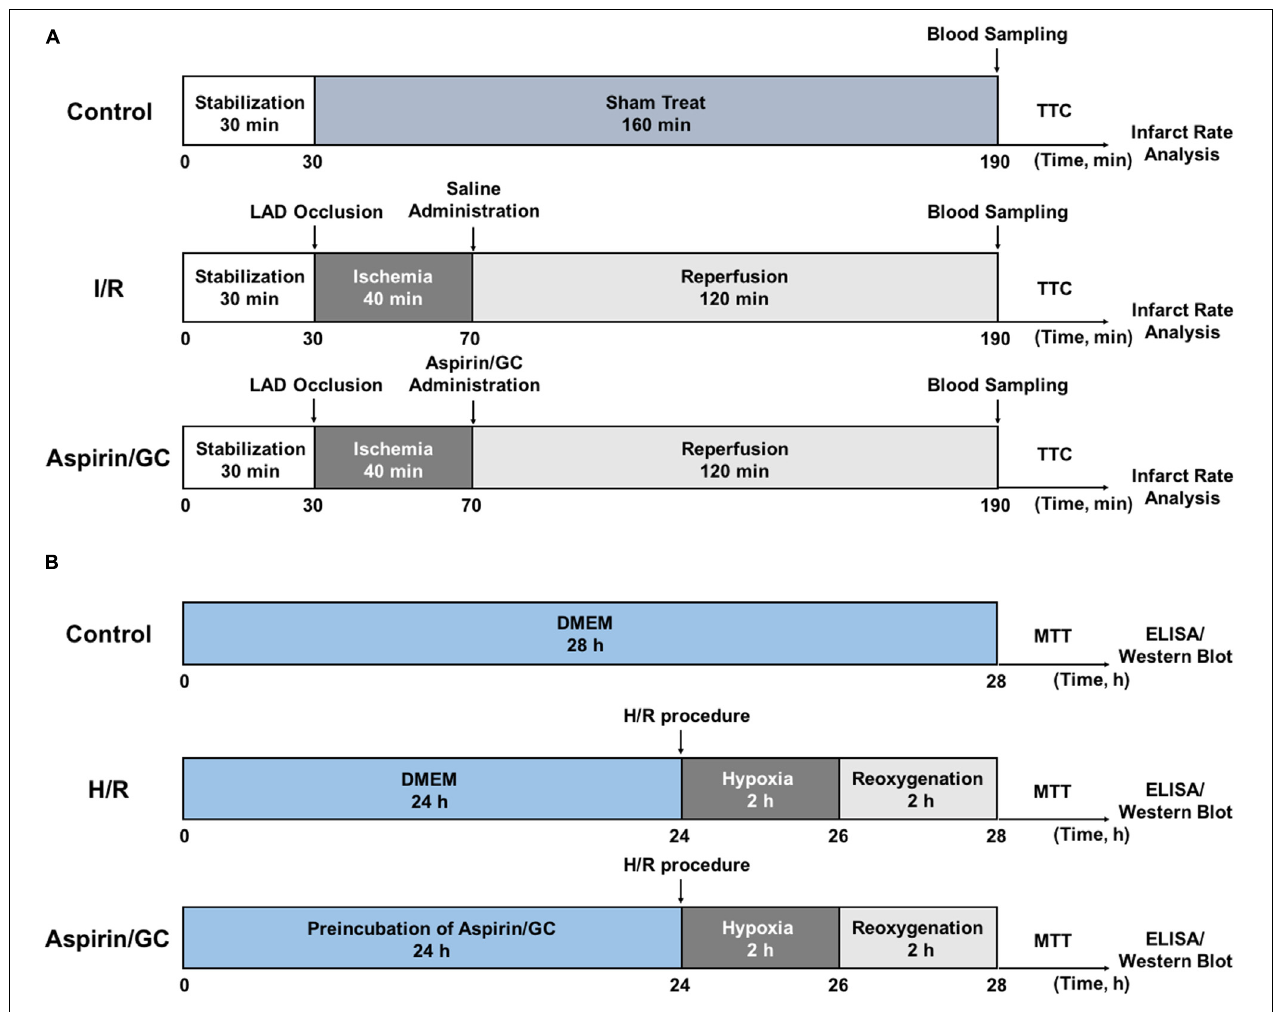
FIGURE 2 | In vivo I/R procedure (A) and in vitro H/R procedure (B)